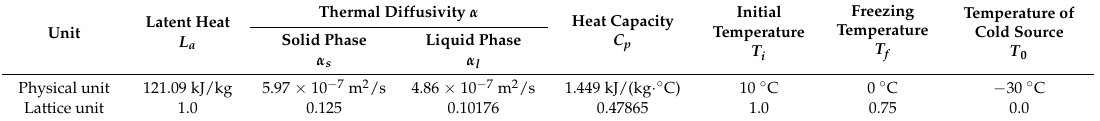
Table 1. Comparisons of thermophysical parameters between physical and lattice units.